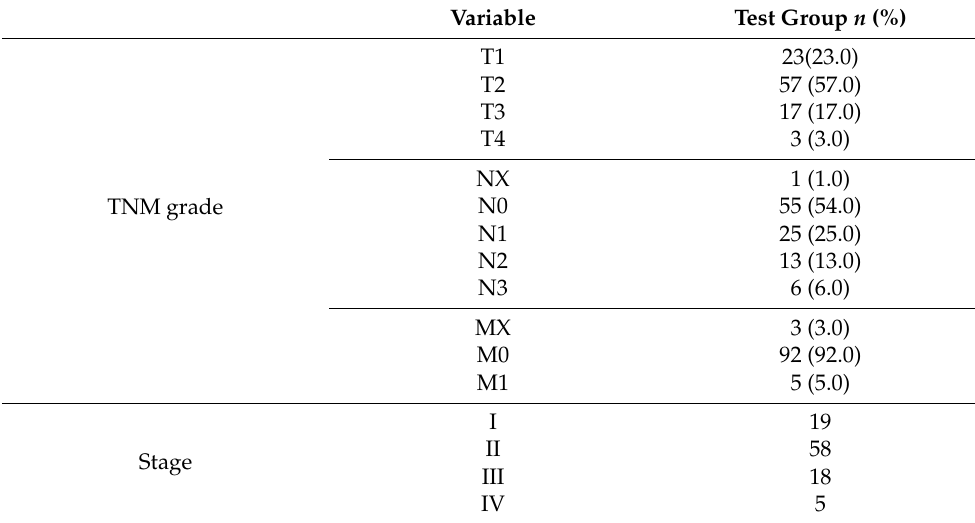
Table 2. Characteristics of the clinical-pathological features of patients.